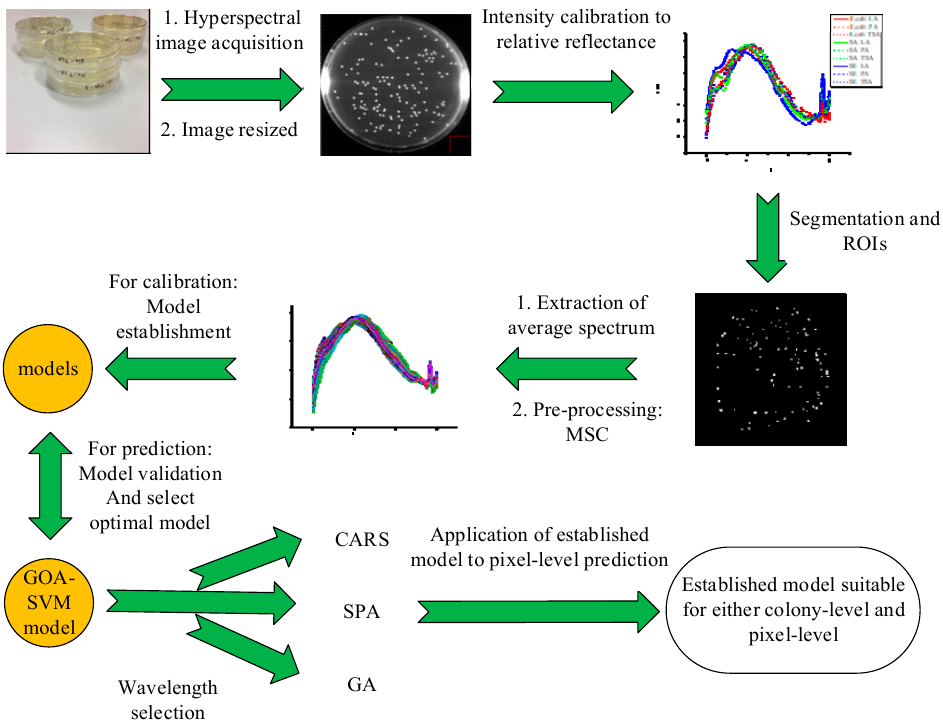
Figure 5. Flowchart of spectral data acquisition and analysis.